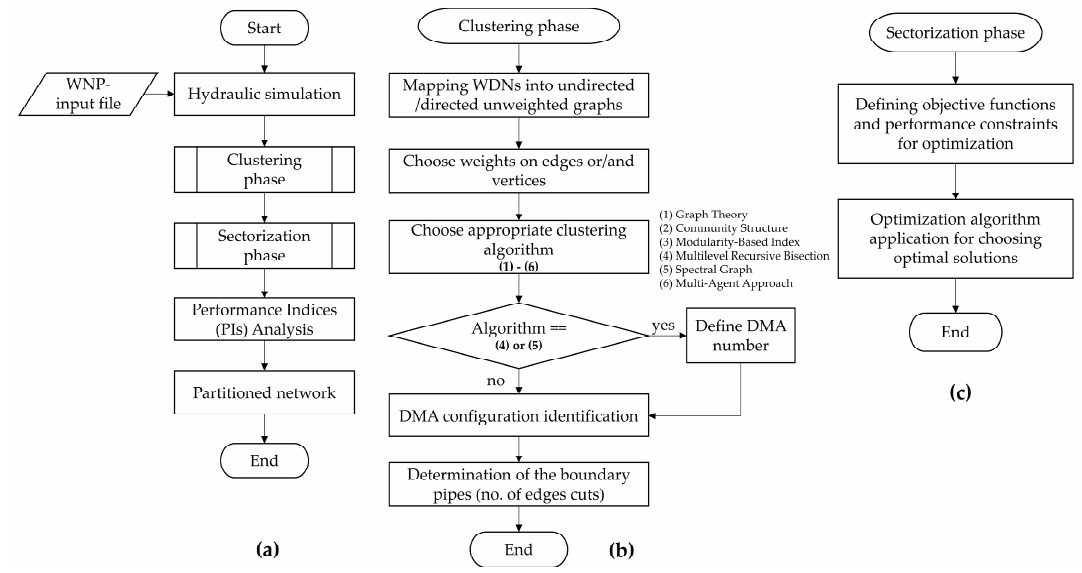
Figure 2. Steps of water network partitioning: ( a ) Overall main procedures, ( b ) steps for clustering, and ( c ) steps for sectorization.